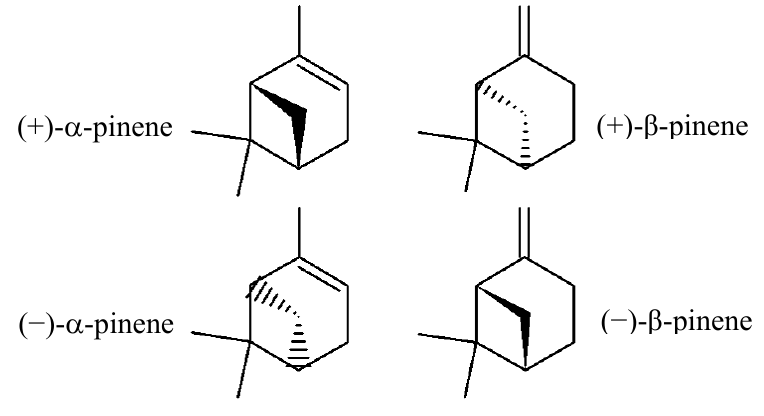
Figure 1. Structural formulas of  -pinene and β -pinene